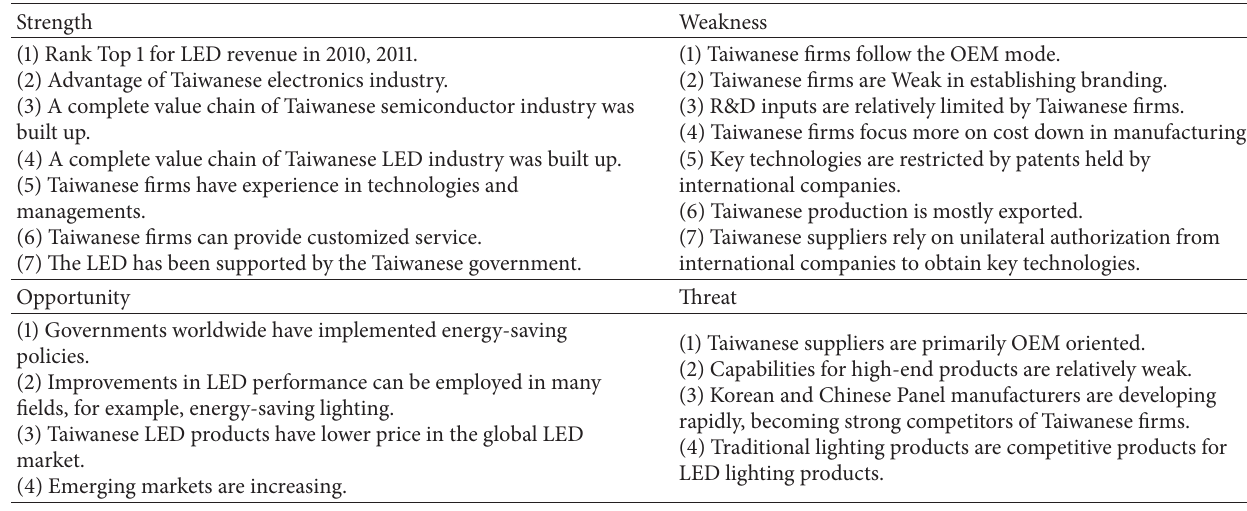
Table 6: SWOT analysis of Taiwan LED